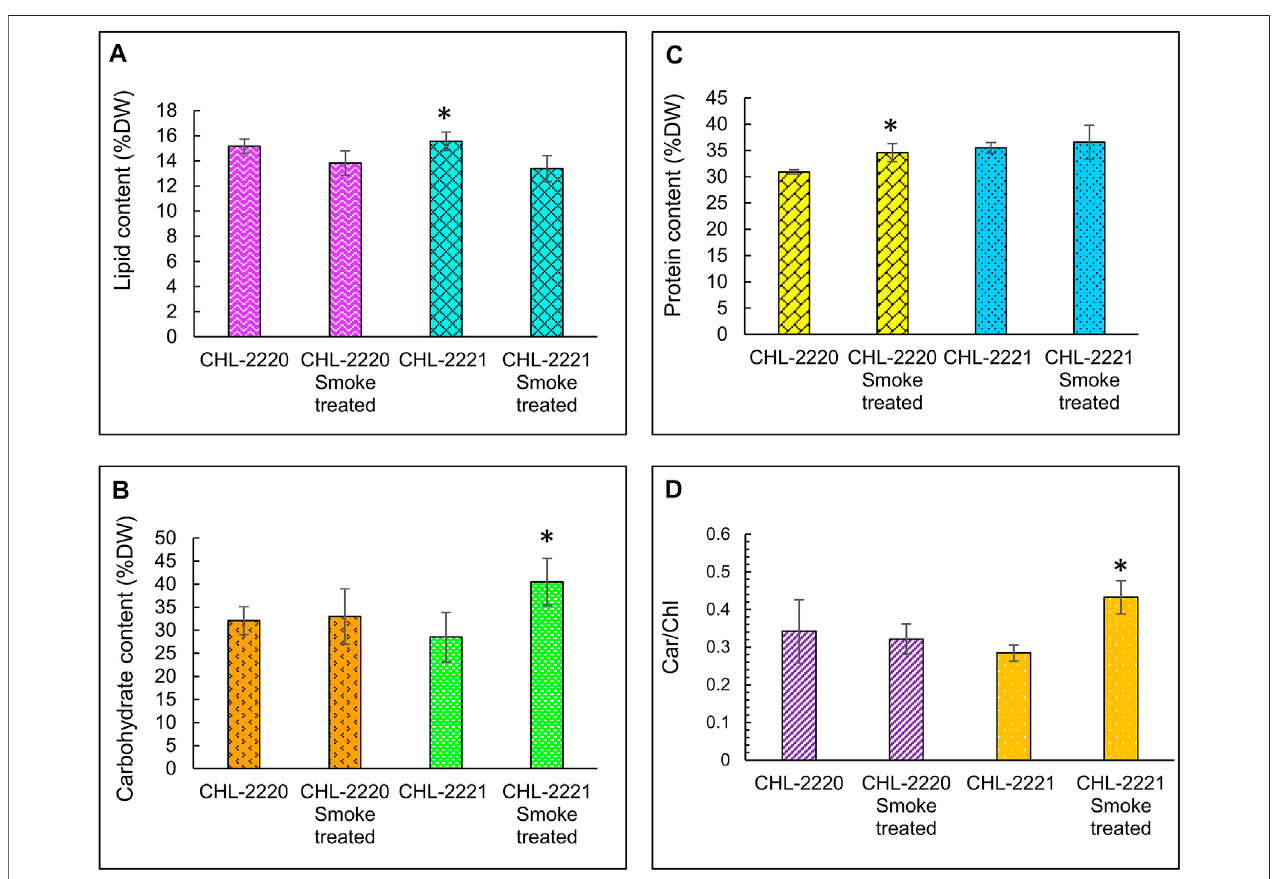
FIGURE 2 | Biochemical and pigment compositions of CHL-2221 and CHL-2220 upon 7-day tobacco smoke exposure and ambient air with Percentage of lipid (A) , carbohydrate (B) , protein (C) and Chl/Caro ratio (D) of CHL-2221 and CHL-2220 upon 7-day tobacco smoke exposure and ambient air.